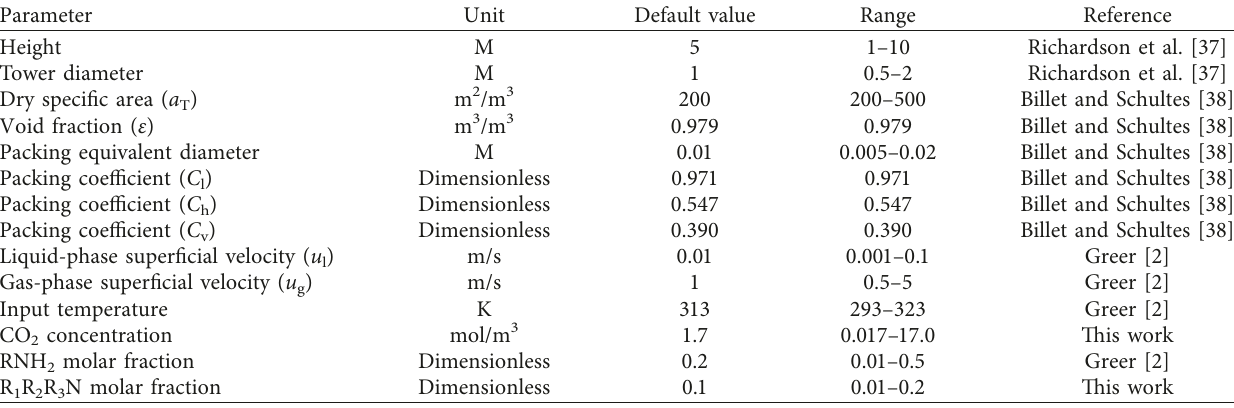
Table 4: Typical values of column geometric parameters and operating